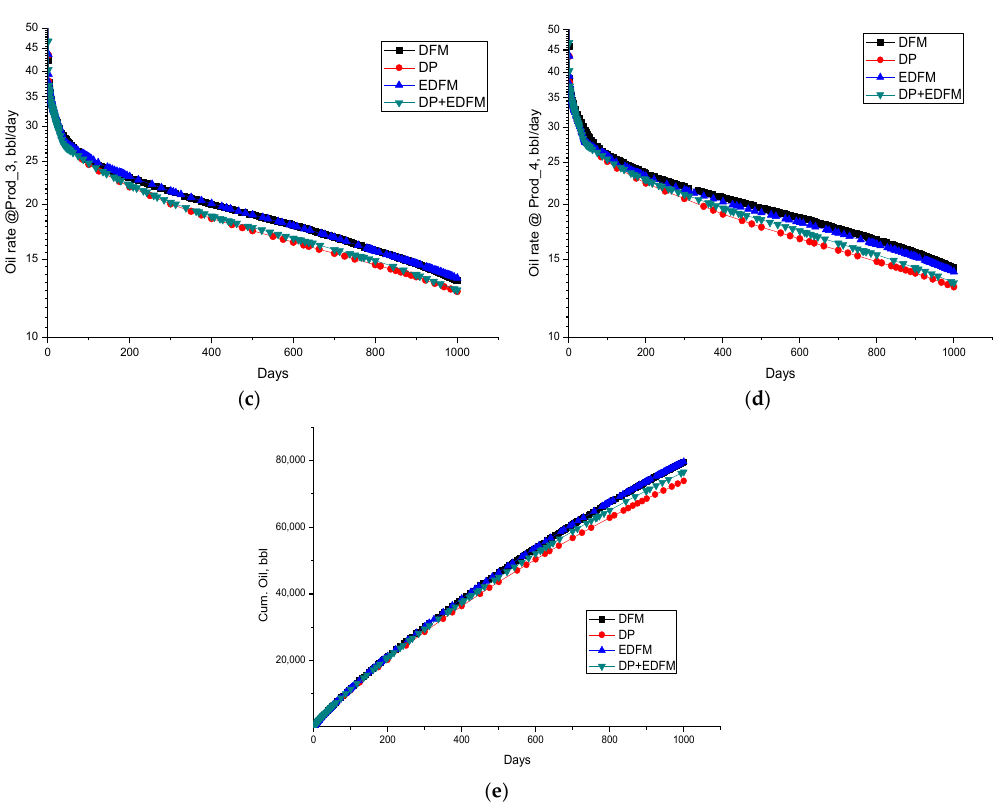
Figure 5. Comparison of production for different models. ( a ) Well “Prod_1” oil rate; ( b ) Well “Prod_2” oil rate; ( c ) Well “Prod_3” oil rate; ( d ) Well “Prod_4” oil rate; and, ( e ) Field cumulative oil.